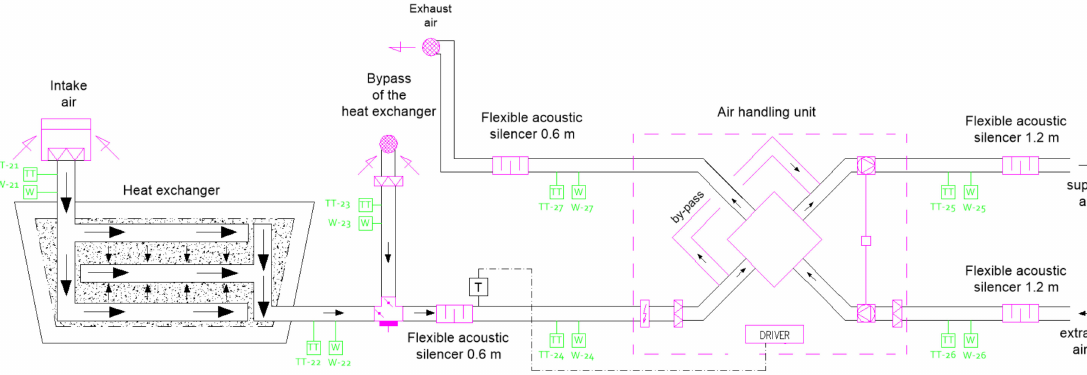
Figure 2. GGAHE diagram.